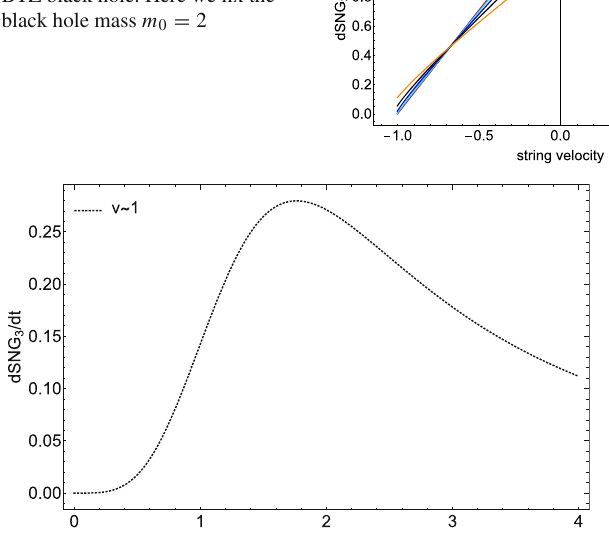
Fig. 2 Left: action growth v.s. string velocity in massive BTZ black hole. Right: action growth v.s. graviton mass in massive